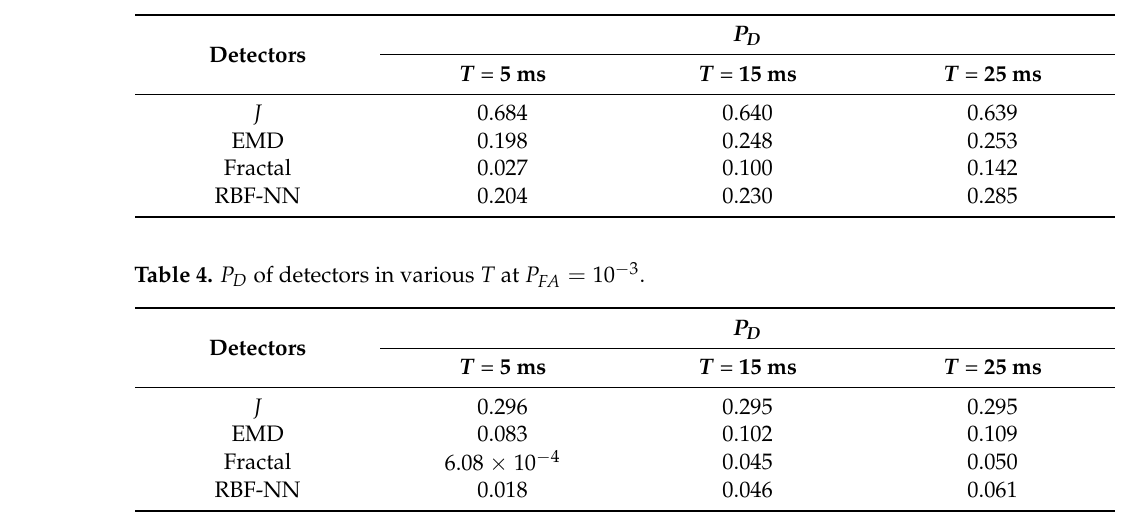
Figure 9. Detection results using ROC curves. Table 3. P D of detectors in various T at P FA = 10 − 2 . (EMD: empirical mode decomposition, RBF-NN: radial basis function-based neural network).